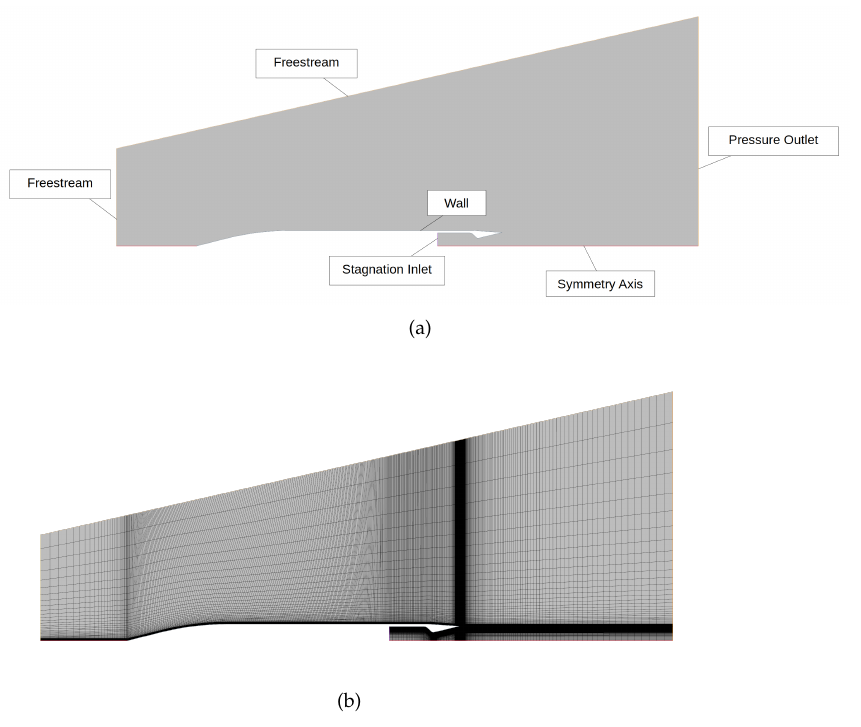
Figure 3. Computational domain with boundary conditions ( a ) and grid ( b